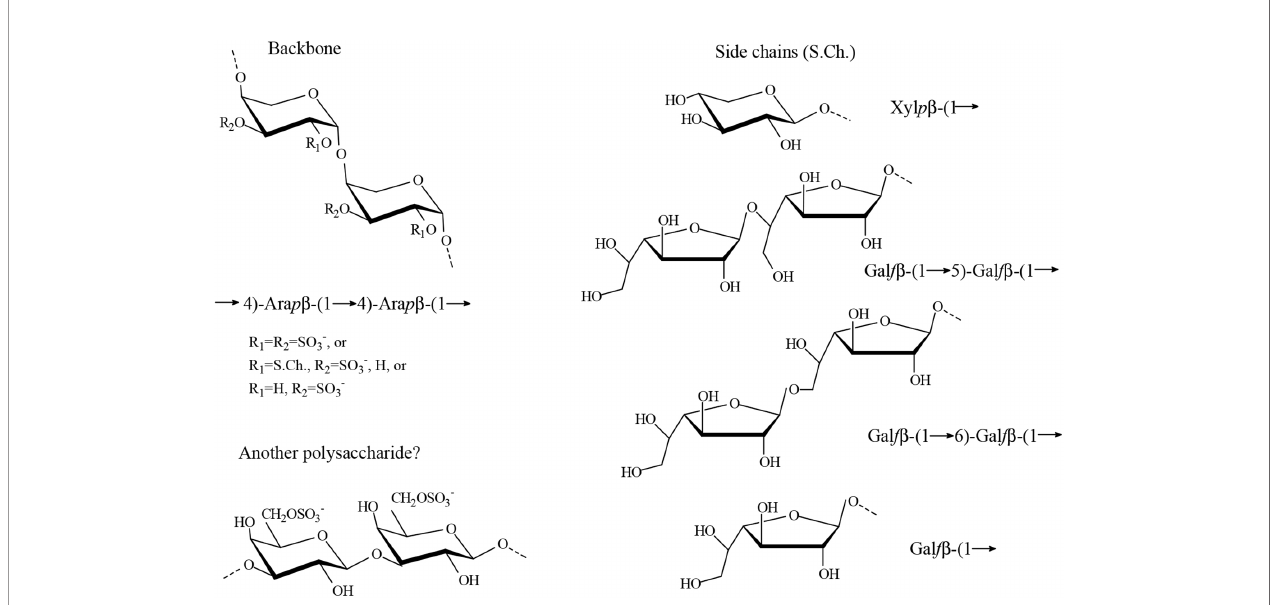
FIGURE 6 | Proposed major structures identi fi ed in the water extracts from Cladophora falklandica (Arata et al., 2016). Furanosic galactan side chains could have different number of units, and each chain could have mixed linkages. In some fractions, 5,6-linked Gal f units were detected. It is speculated that the pyranosic galactan structure constitutes an independent polysaccharide, but this remains to be con fi